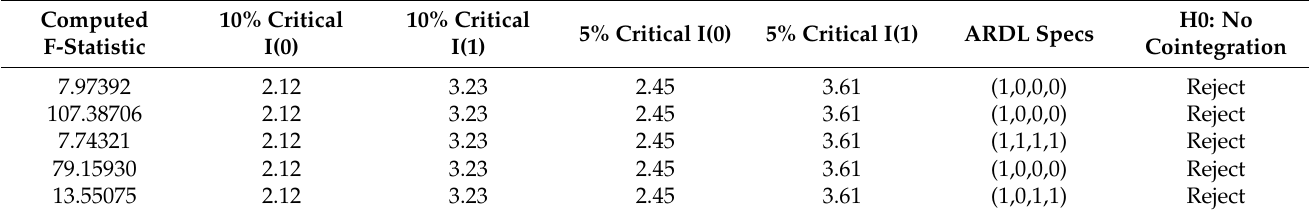
Table A2. The results of the bounds test for cointegration for